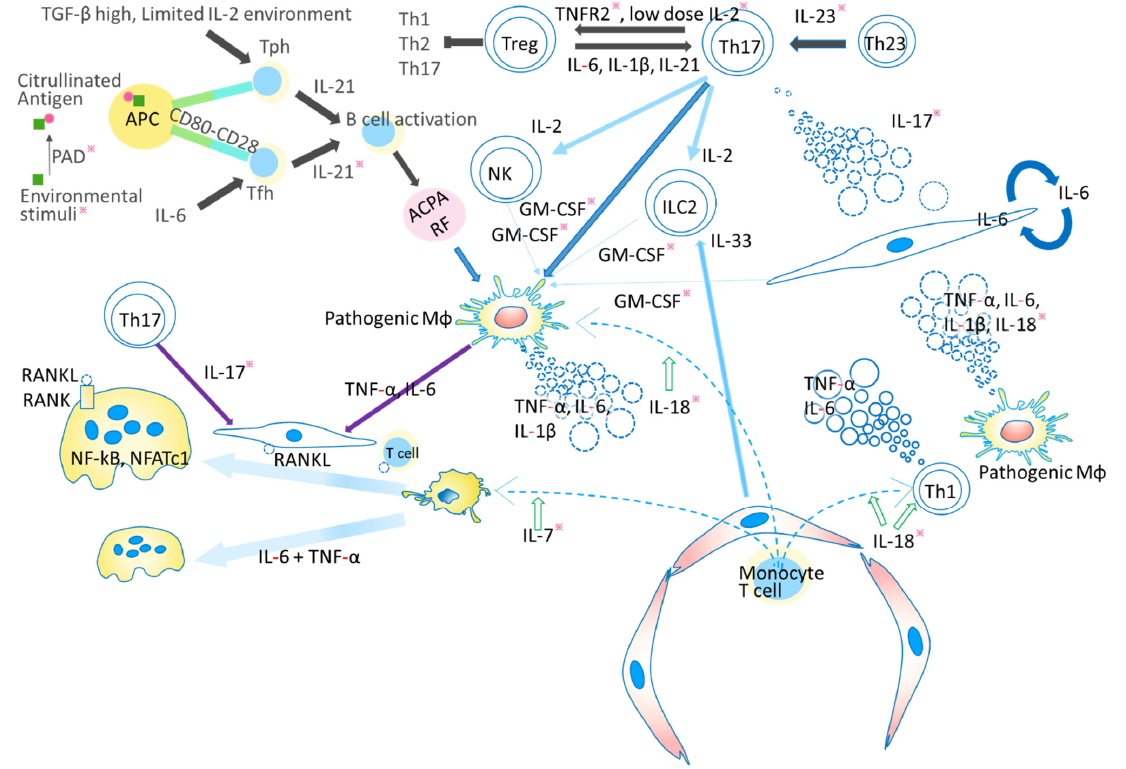
Figure 1. Possible mechanism of joint inflammation and